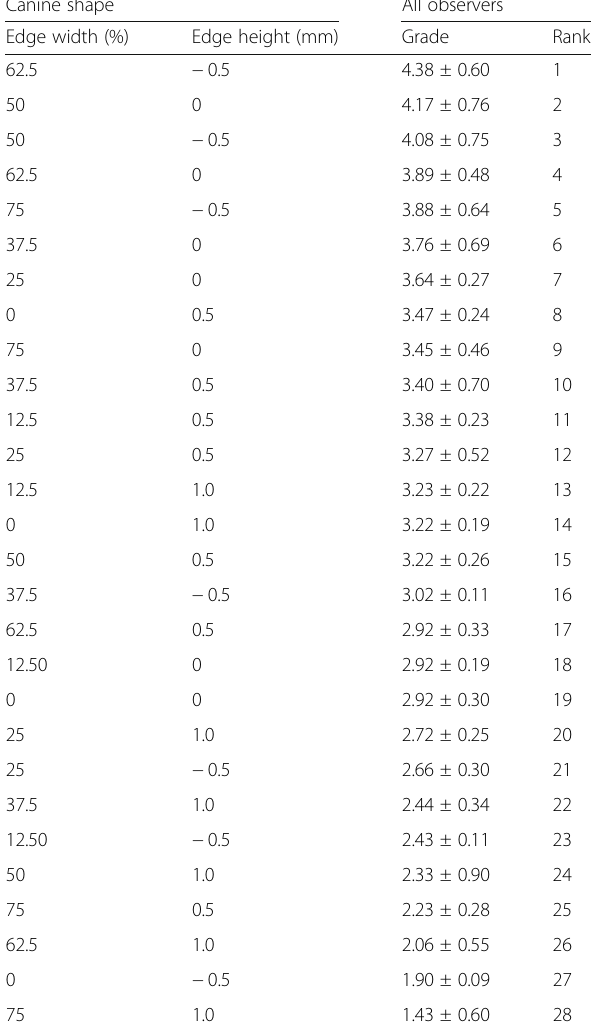
Table 2 Esthetic grade (mean ± standard deviation) and rank on the canine shape by all observers Canine shape All